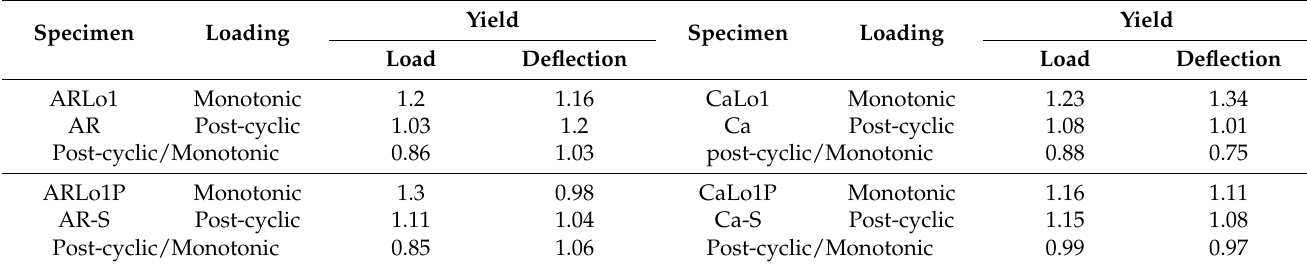
Table 4. Comparison results of flexural behavior in loading for failure.